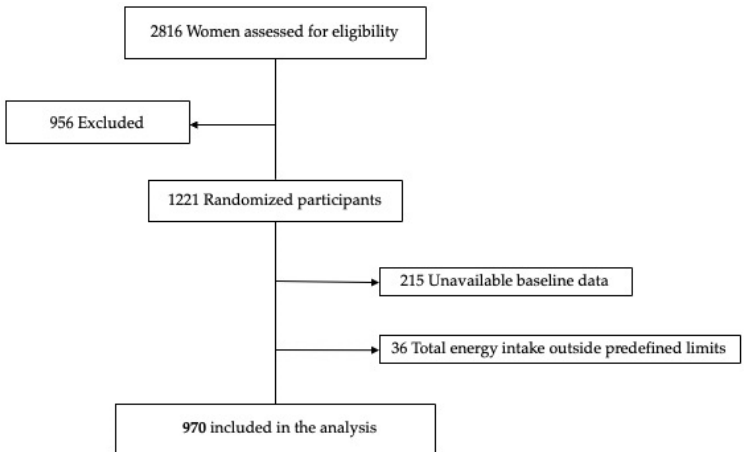
Figure 1. Flow chart of the study population.